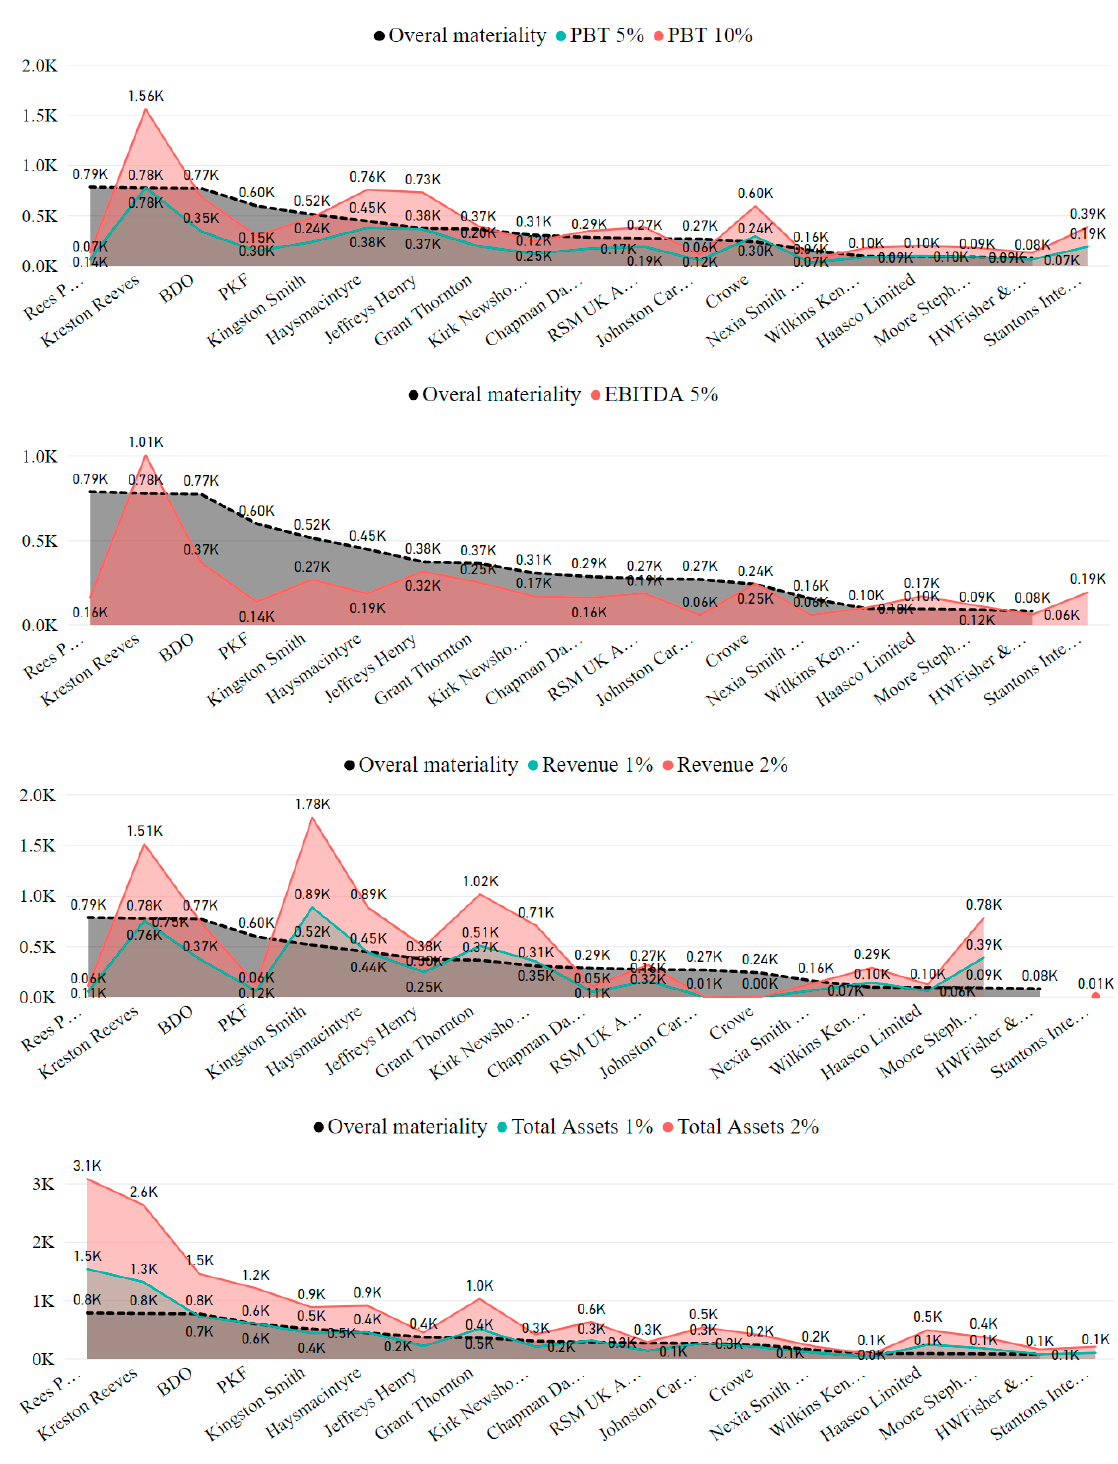
Figure 13. Overall materiality used by non-Big 4 auditors in relation to the percentage mentioned in ISA 320 and literature. Source: own elaboration based on analyzed data.